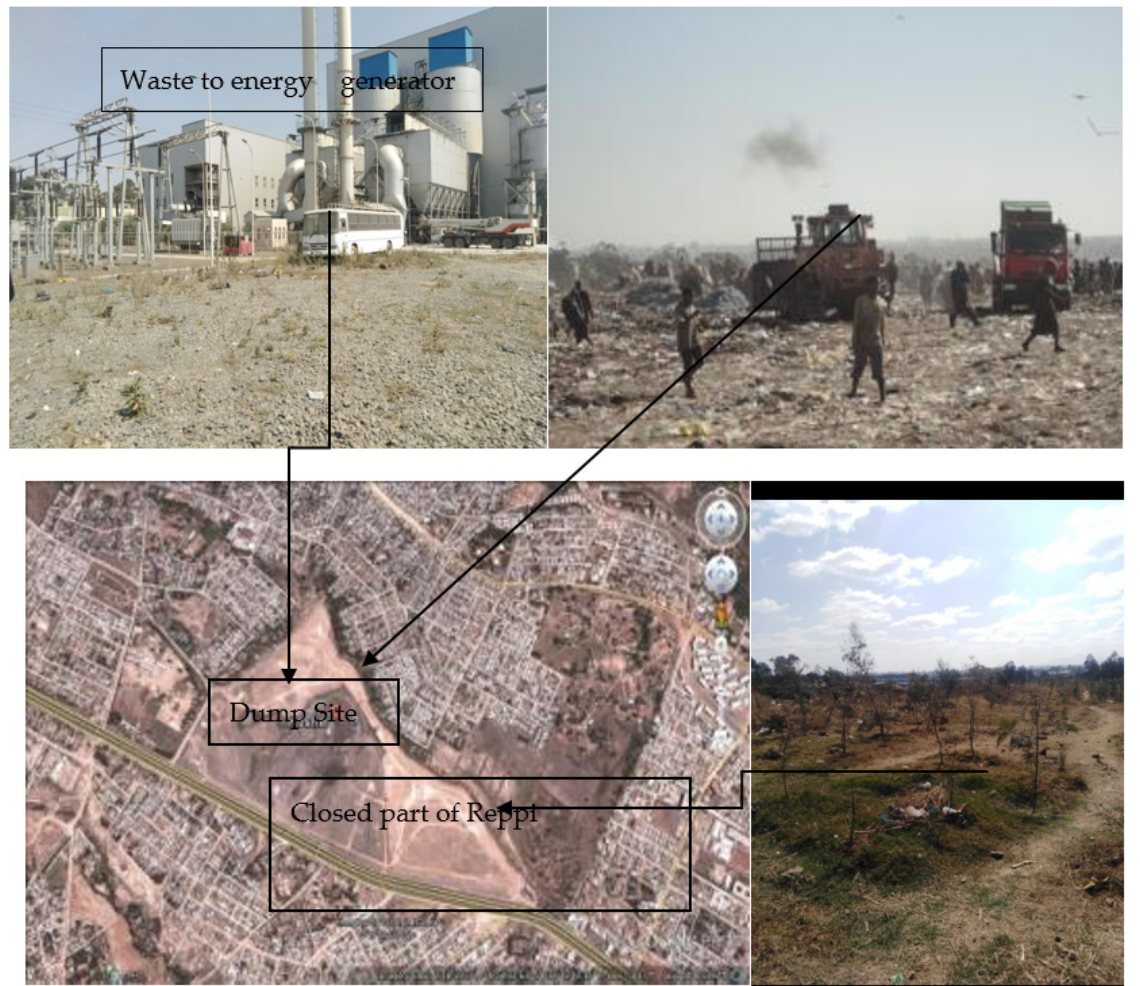
Figure 7. Landfill and reclaimed part of Reppi (Source: Google Earth 2020).